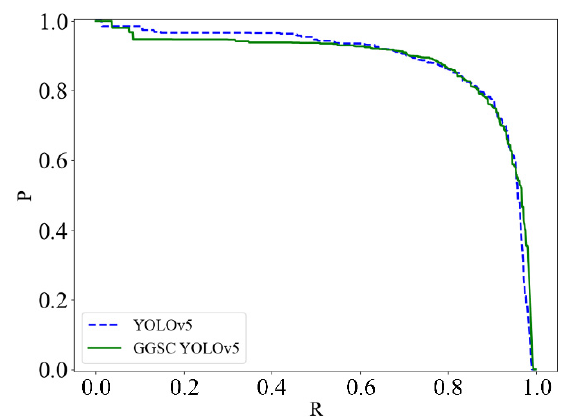
Figure 9. Comparison with R − P curve.